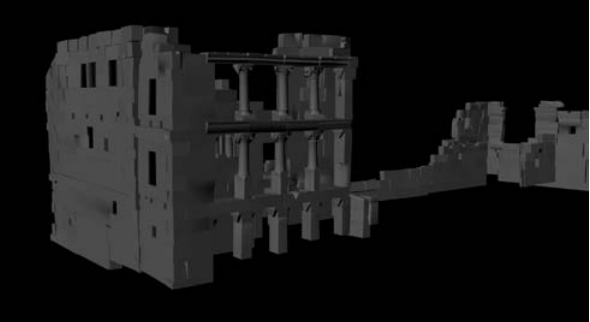
Figure 20. The 3D reconstruction of the actual state of the ‘Résidence’